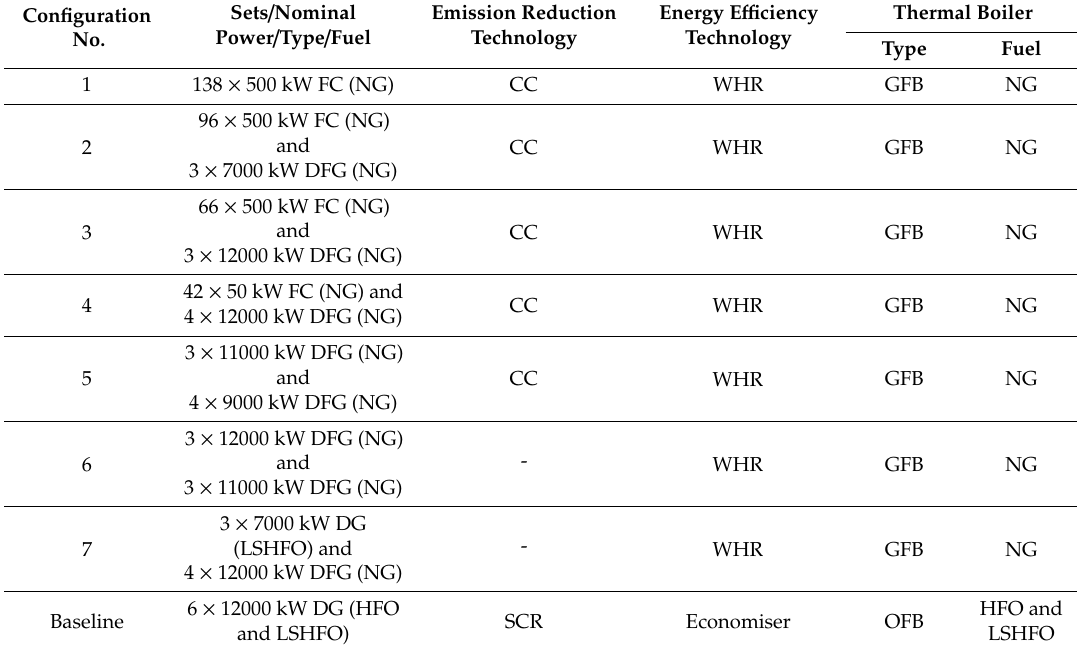
Table 10. Investigated power plant configurations for the cruise